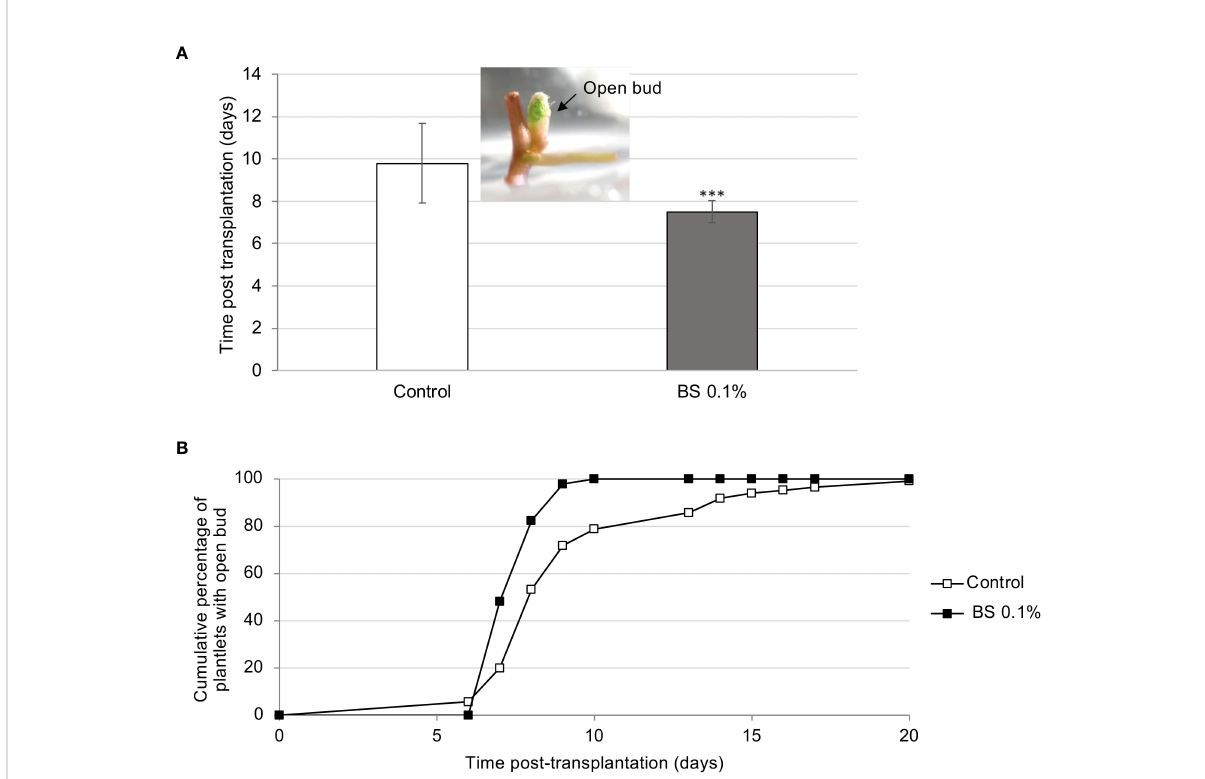
FIGURE 1 Effect of BS treatment on the beginning of development of in vitro grapevine micro-cuttings. Micro-cuttings were transplanted in a solid culture medium supplemented with BS (0.1% v/v) or water (control), and the beginning of their development was compared ( “ open bud ” , with green top of the shoot visible). (A) time (mean number of days) between the date of the micro-cutting transplantation and the date of bud opening. (B) cumulative percentage of micro-cuttings that have started their development (with open bud). Signi fi cant differences were identi fi ed with Student t -test (*** P <